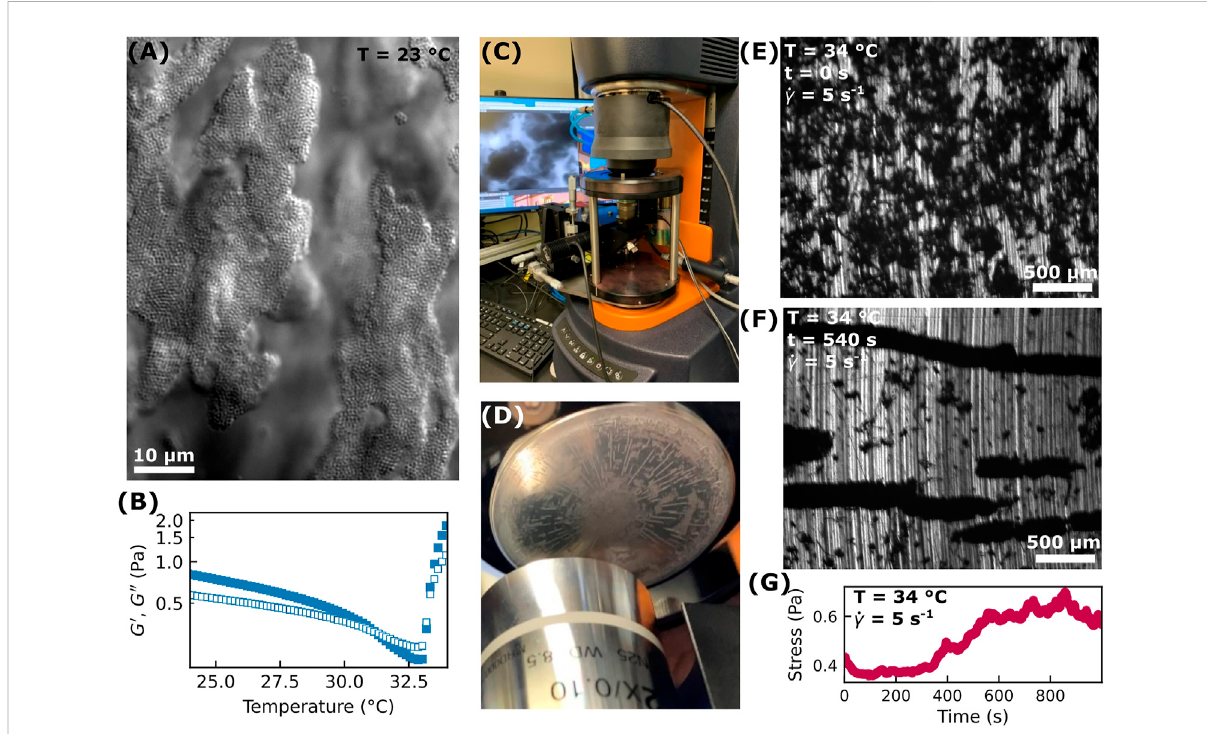
FIGURE 1 (A) At room temperature, the colloid-polymer mixture forms a weak gel as observed with a bright fi eld microscope using a 60× objective lens. (B) As measured with a DHR-3 instrument using a parallel-plate geometry, the storage ( G ′ , solid symbols) and loss ( G ″ , open symbols) moduli vary with temperature. The moduli were obtained using a frequency of ω (cid:1) 10 rad/s with an amplitude of γ 0 (cid:1) 3%. (C) The DHR-3 used for collecting rheology and rheo-microscopy data is shown. The instrument is out fi tted with a temperature-controlled upper plate and a bottom glass plate under which a microscope is placed. (D) A view from underneath the parallel-plate geometry shows a 2× microscope objective placed below the bottom glass plate. The sample shows shear-induced patterning as thin white structures oriented radially outward (in the vorticity direction) can be observed. (E) An image of the colloid-polymer mixture in the parallel-plate geometry after the sample was heated from 23 ° C to 34 ° C at a rate of 0.5 ° C/min.Duringthistemperatureramp,thesamplewasshearedataconstantrateof _ γ T ↑ (cid:1) 5 s − 1 .Thisimagewastakenimmediatelyafterthesample (cid:1) 5 s − 1 while the temperature was held fi rst reached 34 ° C. (F) For the same sample shown in (E) , we continue applying a constant shear at a rate _ γ hold at34 ° C.Thisimageshowsvorticity-aligned fl ocshaveformedat t (cid:1) 540 sintothisstepofconstantappliedshearrateandconstanttemperature.The vertical axis of the image is along the fl ow direction and the horizontal axis is along the vorticity direction. (G) During this period of constant shear described in (F) ,we measure thestress over time. Increases in thestress coincidewith theformation of vorticity-aligned log-like fl ocsas seen bythe uptick in stress at around 500 s which coincides with when the logs seen in (F) begin to